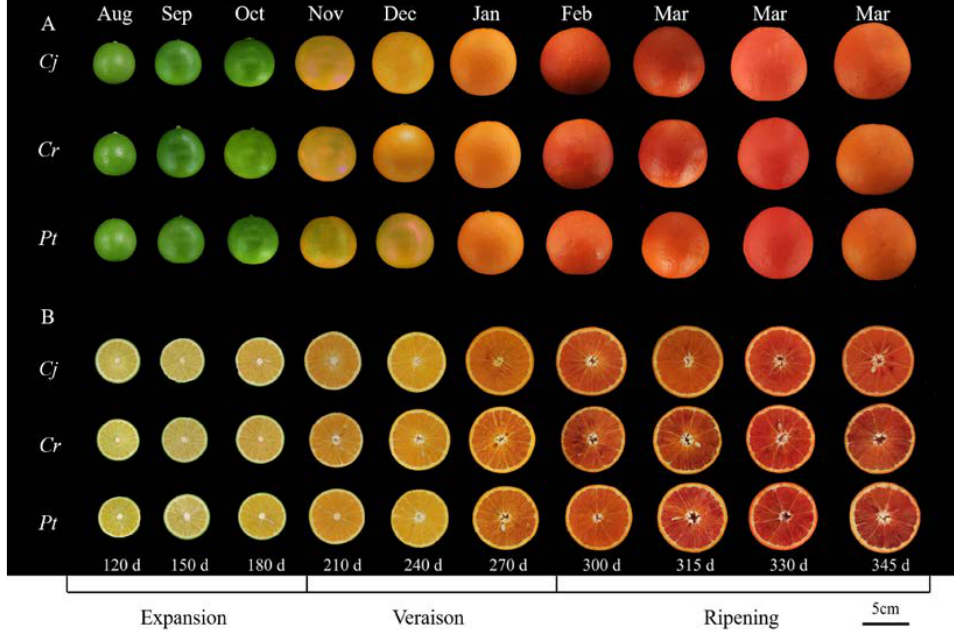
Figure 1. The phenotypic dynamics during the development and ripening of blood orange fruit. ( A ) The change in the external epicarp color. ( B ) The change in the internal color of fruit flesh. The X axis represents different stages of fruit development and ripening. Scale bar represents 5 cm. Cj , Cr , and Pt in the first column represent ‘Ziyang Xiangcheng’ ( Citrus junos Sieb. ex Tanaka), ‘Hongju’ ( C. reticulata Blanco), and ‘Trifoliate orange’ ( Poncirus trifoliata L. Raf.), respectively. The same applies below.